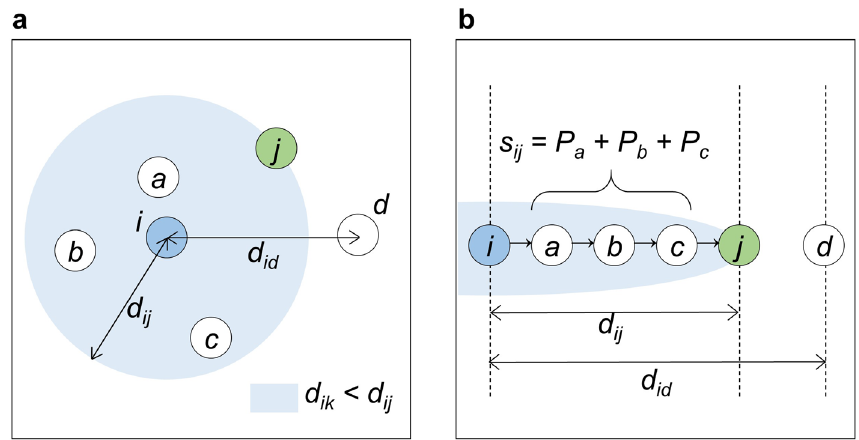
Figure 1. Schematic of intervening opportunities. ( a ) The geographical extent of intervening opportunities based on the distance between origin i and destination j . ( b ) The intervening opportunities s ij composed of the cumulative population of areas in nearby order in the geographical